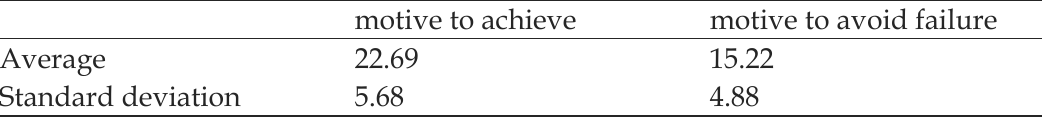
Achievement Motivation motive to achieve motive to avoid failure Average 22.69 15.22 Standard deviation 5.68 4.88 Source: author’s